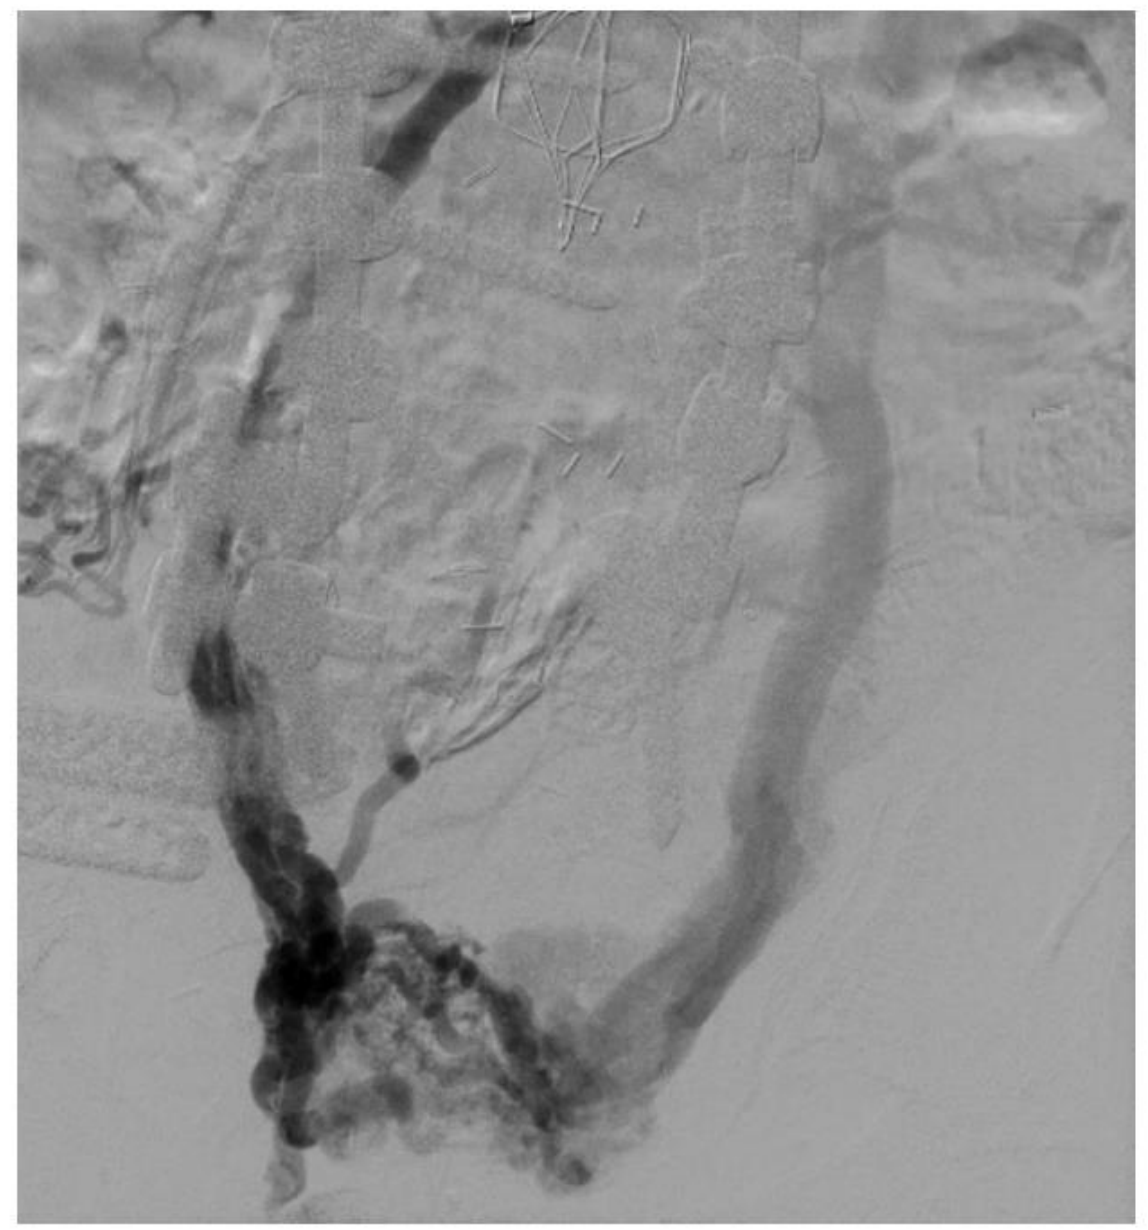
Figure 5. Large pelvic collaterals seen in a patient on venography with bilateral iliac vein occlusion. Also seen is an IVC filter with IVC